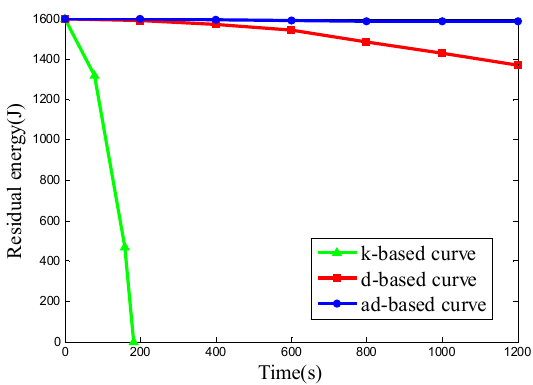
Figure 23. The residual energy of the network in node deployment (c): C 1 is deployed with 50 nodes, C 2 is deployed with 150 nodes, C 3 and C 4 are deployed with 300 nodes.